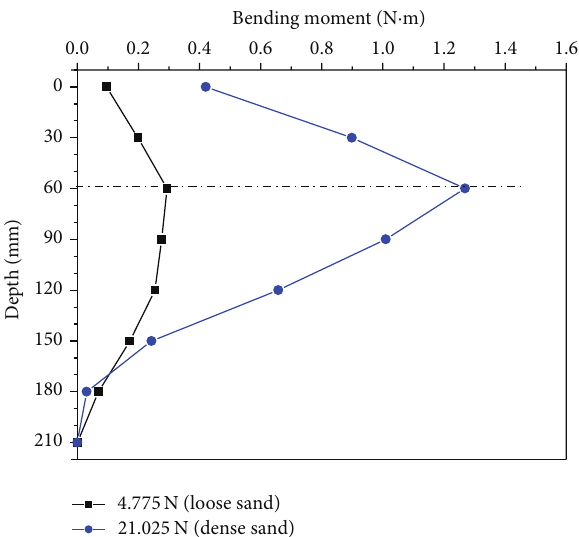
Figure 5: Comparison of the soil resistance in loose and dense